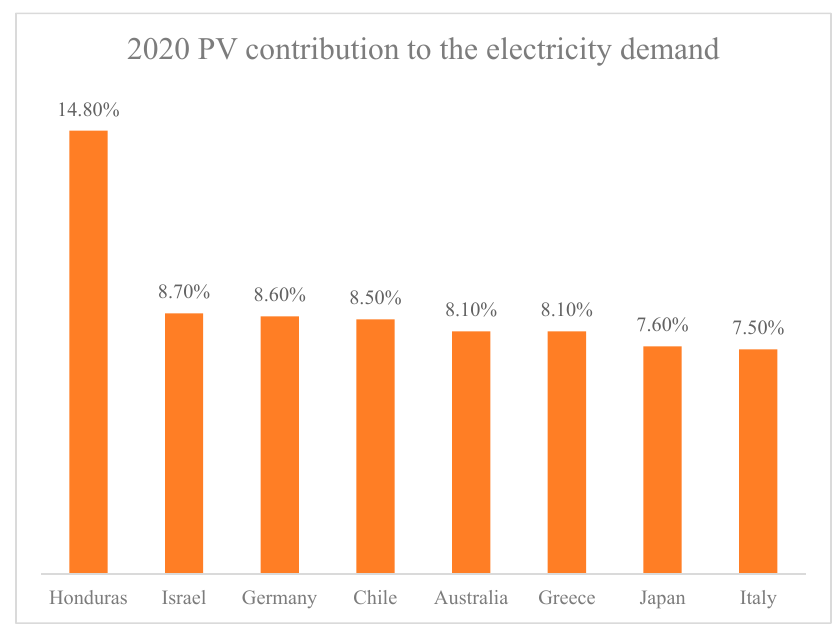
Figure 1. Theoretical PV production by nation (Source: 2018 snapshot of Global Markets—IEA PVPS) .